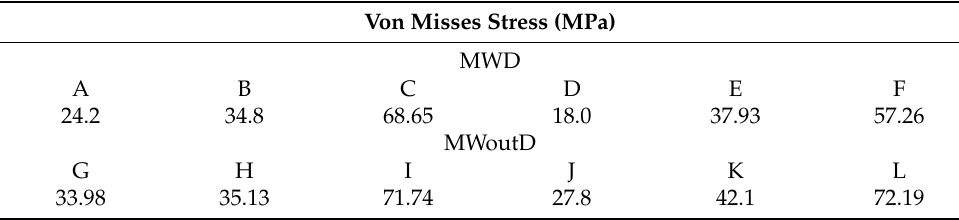
Figure 12. Equivalent von Mises stress distribution for MWD, and MWoutD. A, D, G, and J represent the pad fed with 0 V. B, E, H, and K correspond to the shuttle location of each actuator. C, F, I, and L indicate the pad fed at 2 V. Table 11. Equivalent von Mises stress values for MWD, and